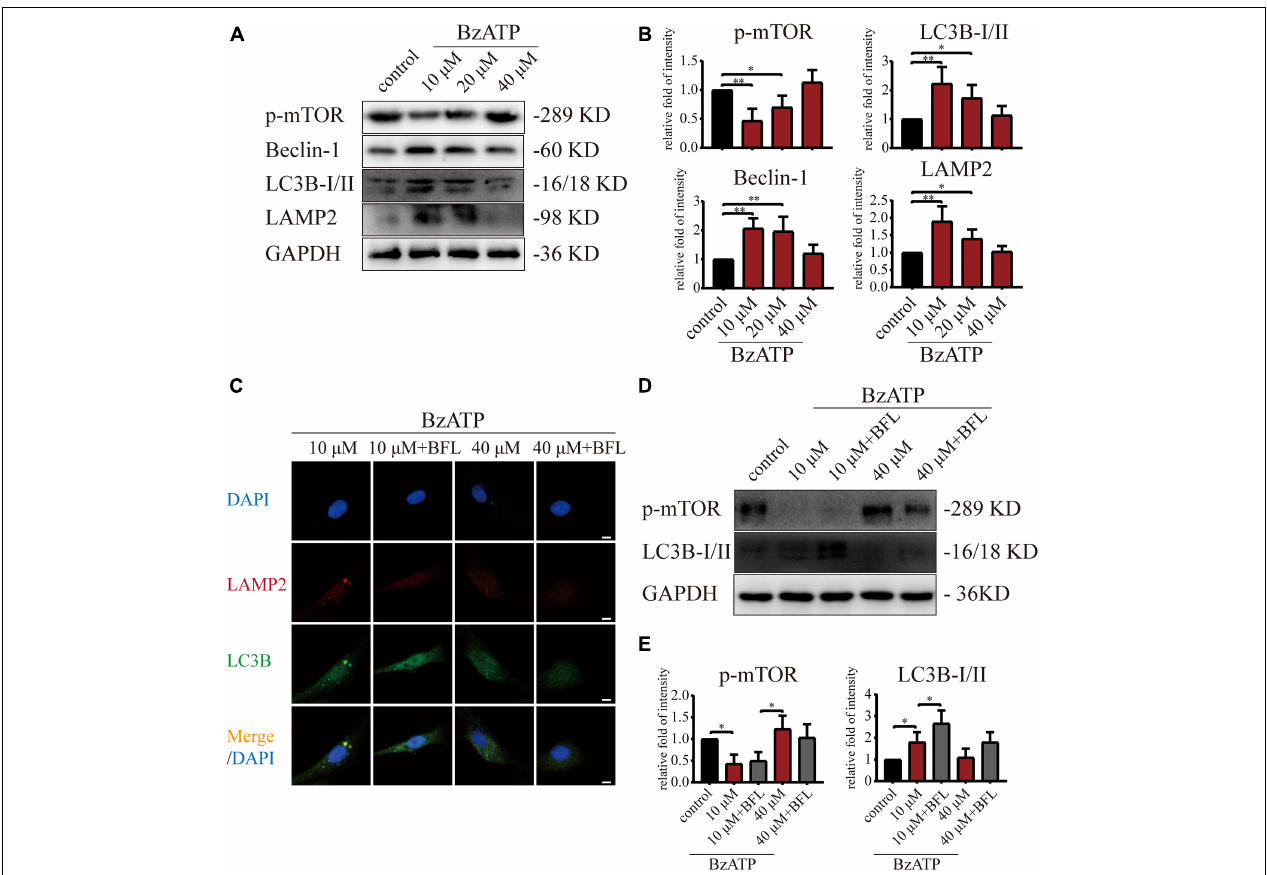
FIGURE 4 | Moderate activation of P2X7 inhibits mTOR and activates autophagic flux. (A,B) Cells were cultured with different concentrations of Bz-ATP (0, 10, 20, and 40 µ M), and the protein levels of p-mTOR, LC3B, Beclin-1, and LAMP2 were detected by western blotting. (B) Quantification of western blotting results. (C) Cells were cultured with 10 and 40 µ M of Bz-ATP, with or without Bafilomycin A1 (BFL), and the localization of autophagosomes and lysosomes was evaluated using immunofluorescence (LC3B: green, LAMP2: red, DAPI: blue) (scale bar: 5 µ m). (D,E) Cells were cultured with 10 and 40 µ M of Bz-ATP, with or without Bafilomycin A1 (BFL), and western blotting was used to detect the protein levels of p-mTOR and LC3B. (E) Quantification of western blotting results. Data are expressed as means ± standard deviations of at least three independent experiments. ∗ p < 0.05, ∗∗ p < 0.01.